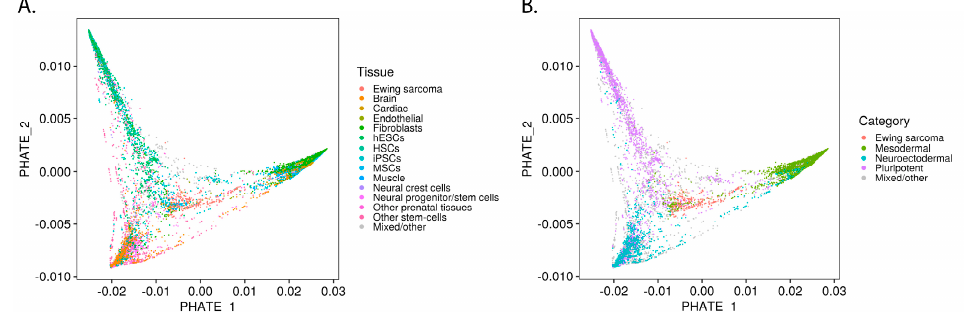
Figure 2. Ewing sarcoma developmental context reconstructed from bulk transcriptomes of Ewing-like tissues: ( A ) PHATE embedding of top Ewing-like samples; ( B ) PHATE embedding labeled by developmental lineage.